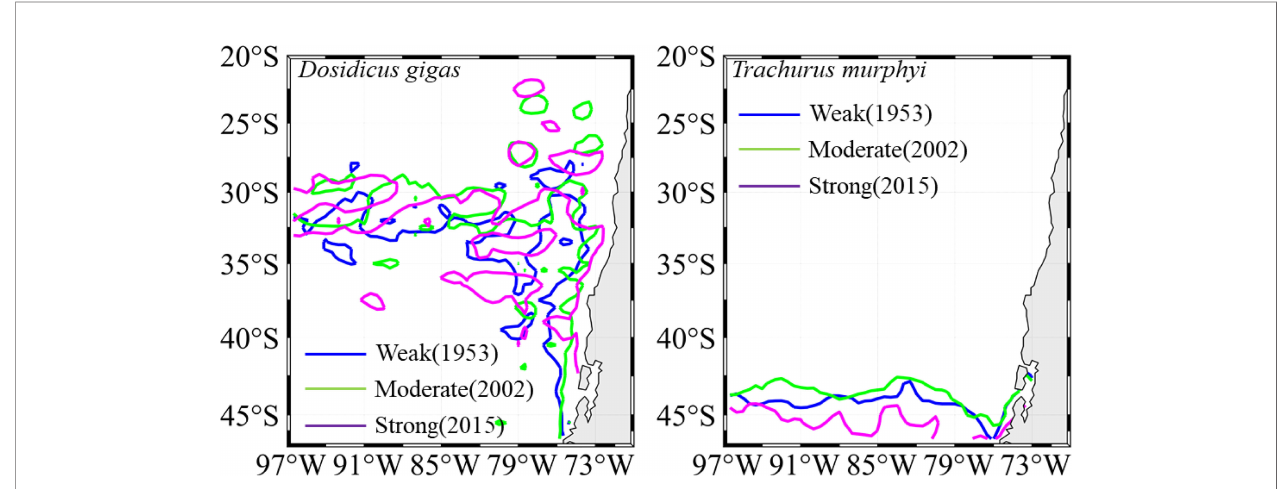
FIGURE 11 | Spatial distribution of the isolines of the most preferred Temp_400 m for Dosidicus gigas and the most preferred SST for Trachurus murphyi in the years of 1953 (weak El Niño), 2002 (moderate El Niño), and 2015 (strong El Niño).